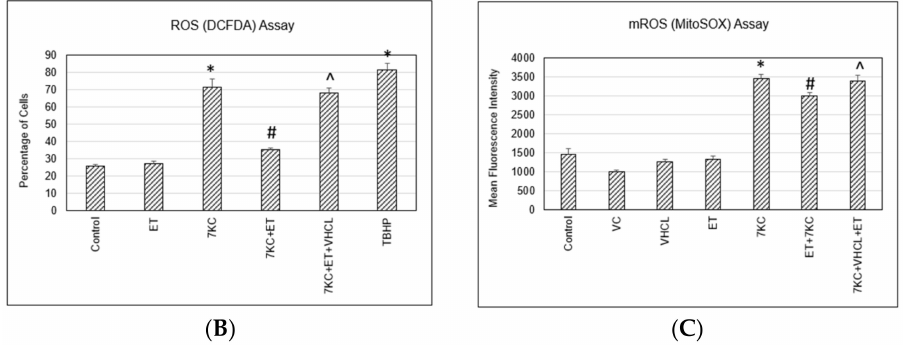
Figure 4. Overall ROS and mitochondrial ROS (mROS) production. ( A ) Individual histograms for overall ROS detection using DCFDA assay. Green: ET + 7KC; Red: 7KC only; Purple: ET only; Black: TBHP only. ( B ) 7KC appeared to induce an increase in overall ROS (ROS) production in cells,